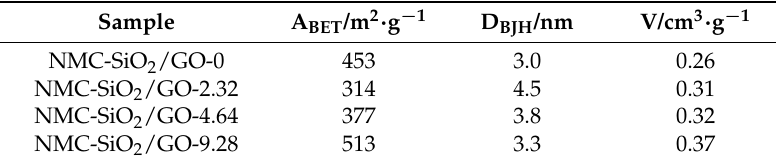
Table 1. Pore features of the synthesized carbon.